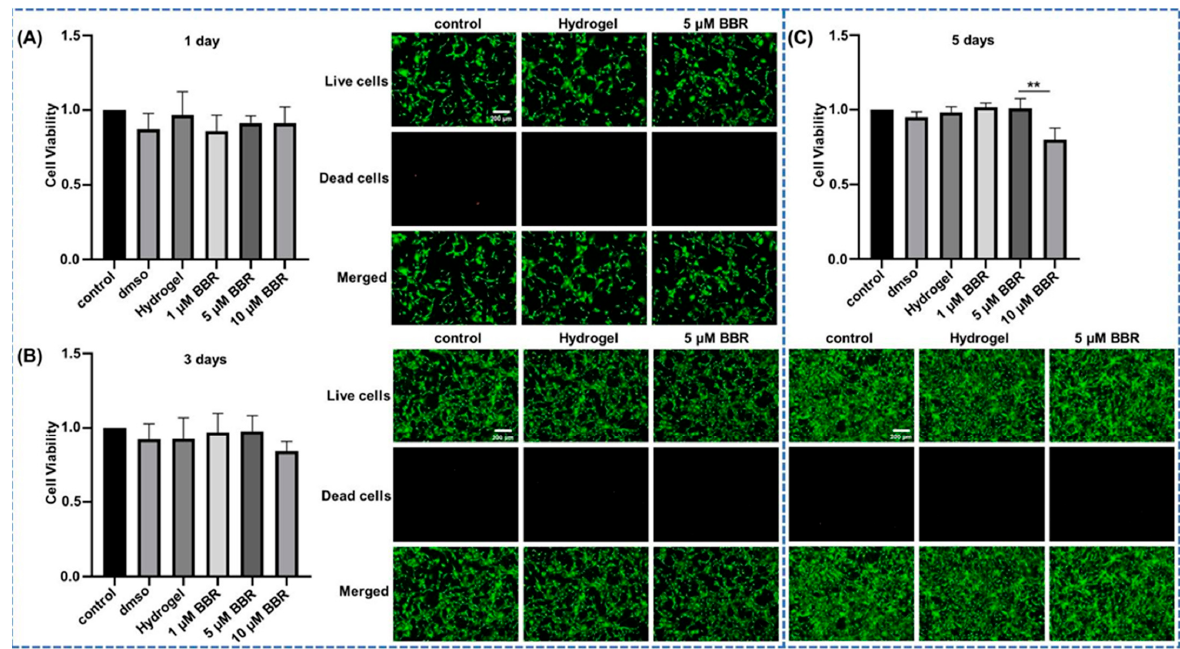
Figure 3. Cytotoxicity of berberine-loaded CS/ β -GP/SA thermosensitive hydrogel in MC3T3-E1 cells. Viability of MC3T3-E1 cells cultured with berberine-loaded CS/ β -GP/SA thermosensitive hydrogel at different concentrations (1–10 µM) at 1 Day ( A ), 3 Days ( B ) and 5 Days ( C ). Green represents living cells, and red represents dead cells. **: p < 0.01.